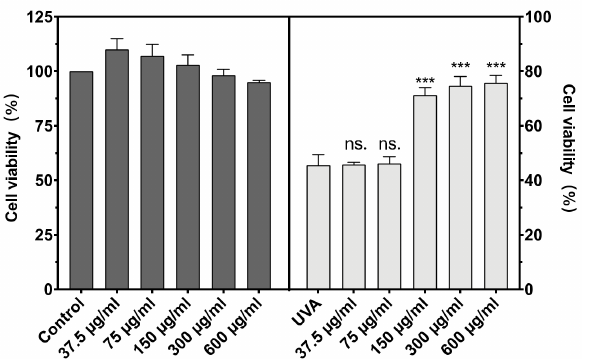
Figure 2. Cytotoxicity of BAL1 (Left) and cell survival rate after UVA damage (Right). Difference analysis between sample group and UVA model group: ns.: p > 0.05, ***: p < 0.001.